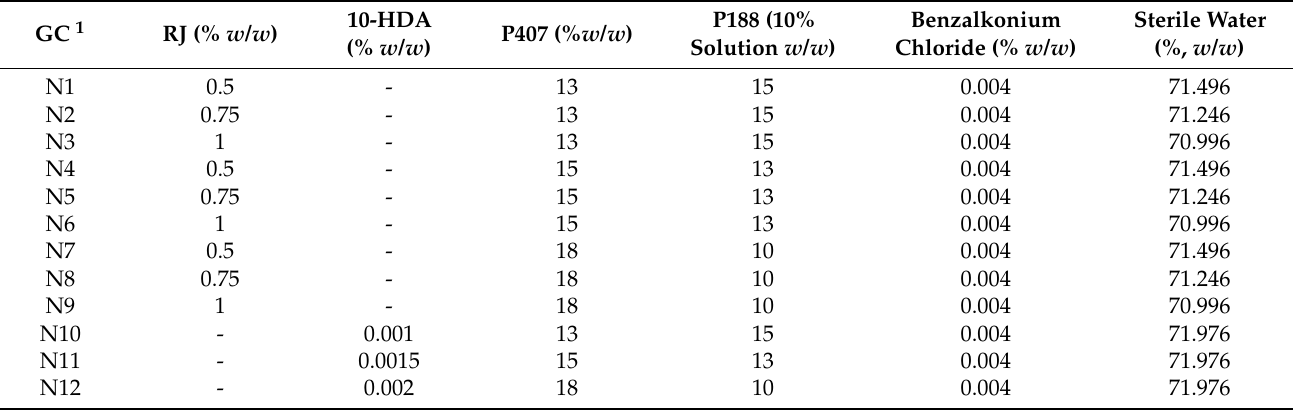
Table 4. Compositions of the in situ forming gels with RJ and 10-HDA.